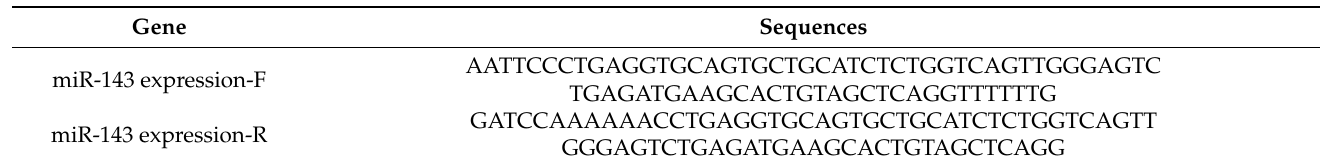
Table 2. Insert sequence in lentiviral